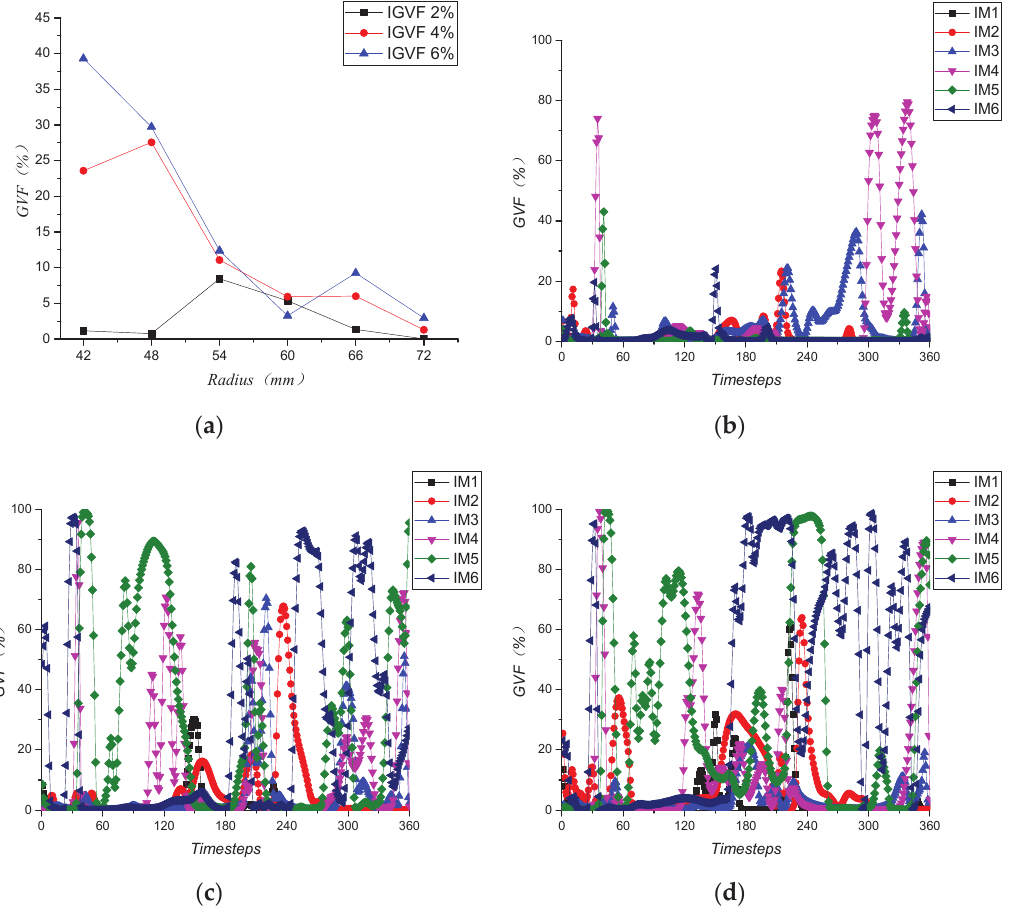
Figure 18. GVF change under different IGVF, ( a ) average, ( b ) IGVF 2%, ( c ) IGVF 4%, ( d ) IGVF